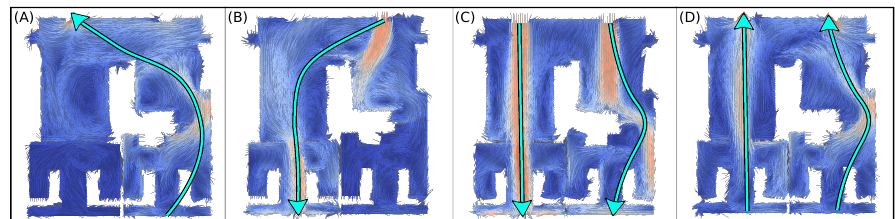
Figure 3. Four different wind simulations ( A – D ) for the multi-room environment as a result of different OpenFoam parameters. In all cases, a “slice” filter (at 0.5 m from the floor to appreciate the obstacles) has been applied to show only a 2D plane of the environment. Vectors represent the direction of the wind at each point, while the color represents the wind strength. Light-blue arrows depict the main wind flow direction within the environment. In all cases, wind strength at the inlets has been set to 1